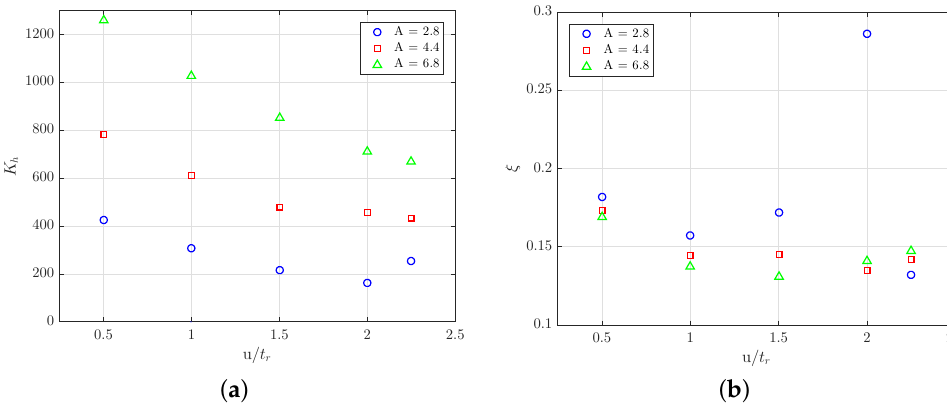
Figure 17. ( a ) Effective horizontal stiffness, k h , and ( b ) equivalent damping ratio, ξ , under different compression levels.